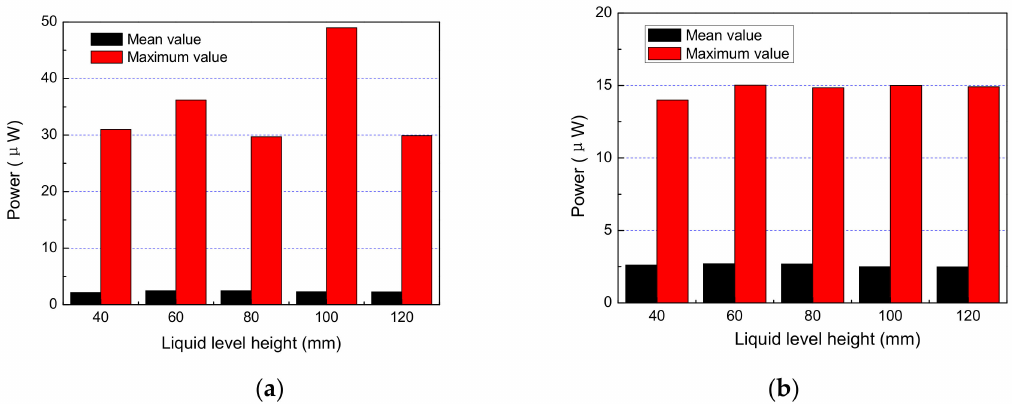
Figure 7. Bar graph of the hybrid energy harvester output power information: ( a ) Piezoelectric transducer; ( b ) Electromag- netic generator.